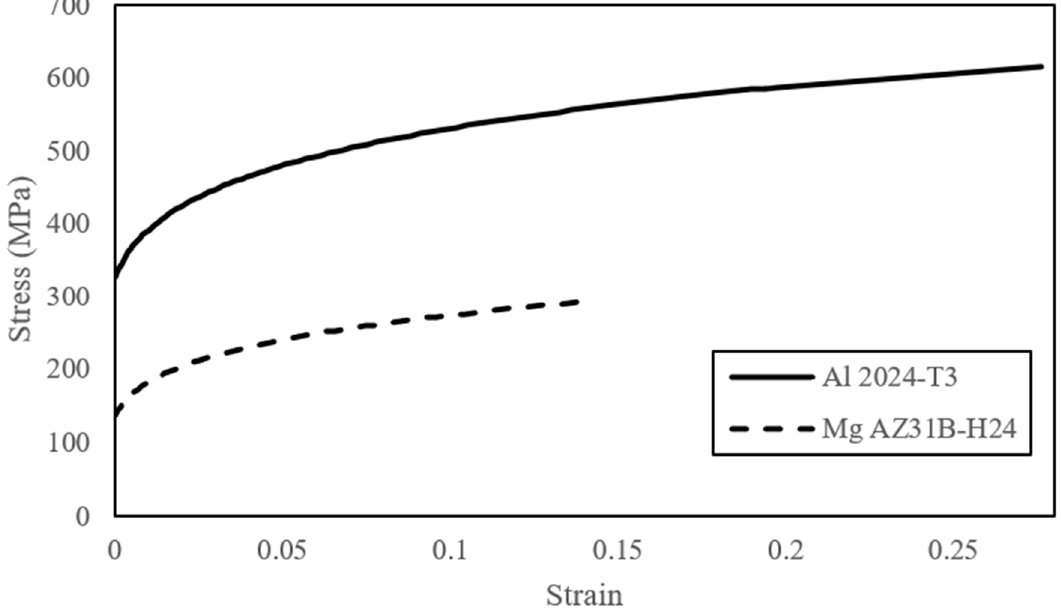
Figure 6. Stress–strain curves representation of the metals’ plasticity. Table 1. MAT_24 parameters.